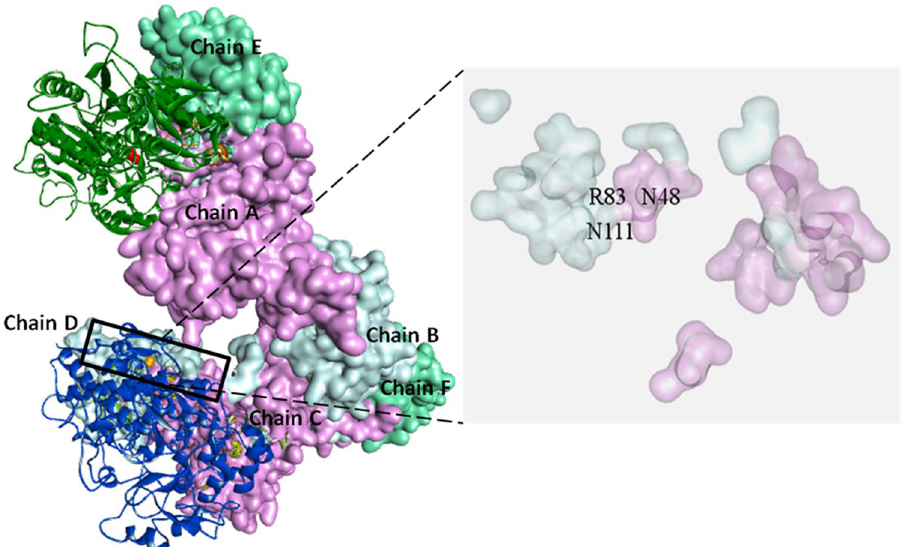
Figure 6. Docking model of AMP-activated protein kinase (AMPK, PDB ID: 4CFF, chain A, C "catalytic subunit, pink surface", chain B, D "beta1 subunit, light blue surface", chain E, F "gamma-1 subunit, light green surface") with LP-CNPs (blue cartoon, the orange space-filling spheres style refers to the interacting CuO) and LF-FNPs (green cartoon, the red space-filling spheres style refers to the interacting Fe 3 O 4 ). The magnified residues elucidate the matched residues with the AMPK-activator (thienopyridone derivative) binding residues . The protein-metal docked complexes were given by the HDOOK server (http:// hdock. phys. hust. edu. cn/), while protein–protein docked complexes were obtained by the PatchDock server (https:// bioin fo3d. cs. tau. ac. il/ Patch Dock/ php. php). All the provided docked complexes were visualized by by Discovery Studio 2020 Client software 20.1 (https:// www. 3ds. com/ produ cts- servi ces/ biovia/ produ cts/ molec ular- model ing- simul ation/ biovia- disco very- studio).